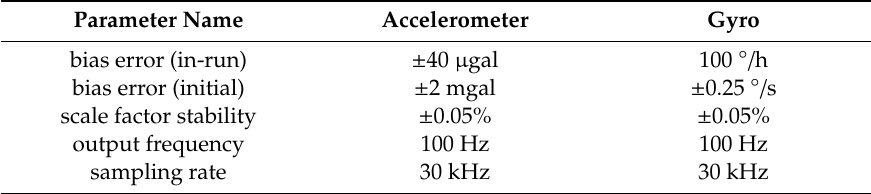
Figure 6. Experimental equipment. Table 2. Parameters of Micro-Electro-Mechanical System (MEMS).